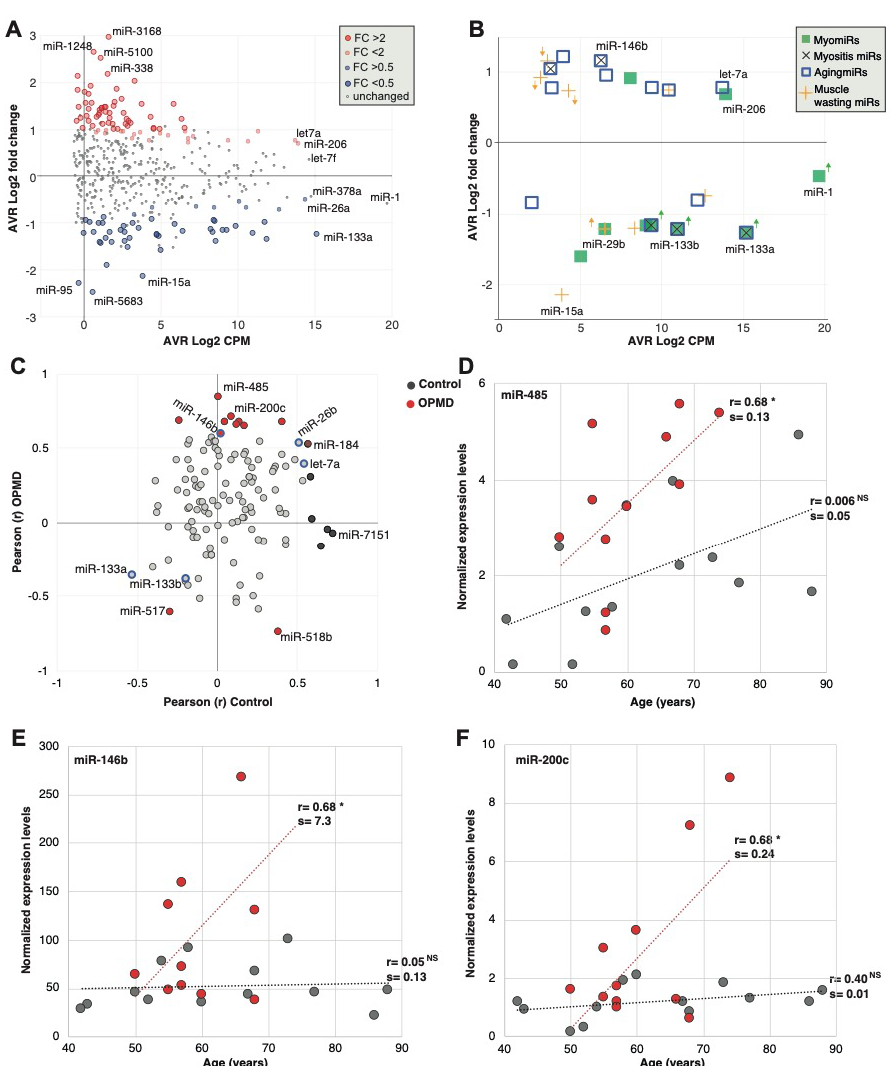
Figure 3. Analysis of miRNAs in human OPMD muscles. ( A ) Scatter plot shows average count per million (CPM, log 2) versus average fold-change (log2) in OPMD versus control muscles. The OPMD upregulated miRNAs are depicted in red, and the downregulated in blue, and those with fold-change > 2 or < 0.5 with a larger circle. The name of most abundant miRNAs and those with the highest fold-change is depicted. ( B ) Scatter plot shows average CPM versus average fold-change in OPMD for selected miRNAs that have been reported to be associated with several muscle pathologies and physiological conditions: The myomiRs are reported in muscular dystrophies; myositis miRs are reported in pathologies with muscle inflammation; AgingmiRs have been reported in aging muscles, and muscle wasting miRs have been reported in models with muscle atrophy and wasting. The miRNAs whose dysregulation direction di ff ers between OPMD and the reference condition are marked with an arrow, and its color refers to the condition. Di ff erences in dysregulation directions were found for muscular dystrophies and muscle wasting. ( C ) Scatter plot of the Pearson correlation coe ffi cient (r) of miRNA expression levels with age in control and OPMD subjects. Analysis was carried out for the OPMD-deregulated miRNAs (pFDR < 0.05). The significantly correlated ( p < 0.05) miRNAs in OPMD are depicted in red, and in control in black. The reported aging-associated miRNAs, miR-133a / b, miR-146b, miR-26b and let-7a are blue encircled. ( D , F ). Scatter plots of expression values versus age in three significantly age-correlated and OPMD-deregulated miRNAs. Controls are depicted in grey and OPMD in red. A dotted line shows a linear regression line, the correlation coe ffi cient (r) is denoted. Pearson p -value < 0.05 is denoted *, respectively, or non-specific (NS). The slope ( = s) of the regression line was determined with a linear regression